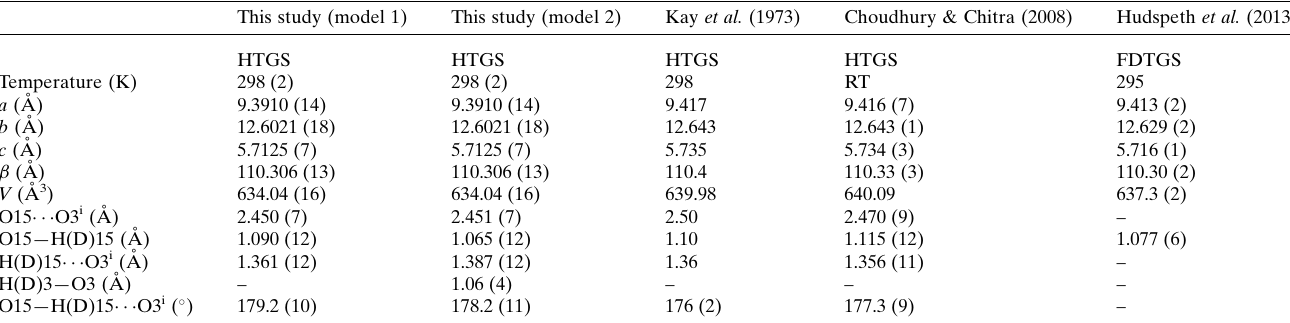
Table 2 Lattice constants, interatomic distances and angles at disordered atoms for HTGS and FDTGS at (cid:5) 298 K.